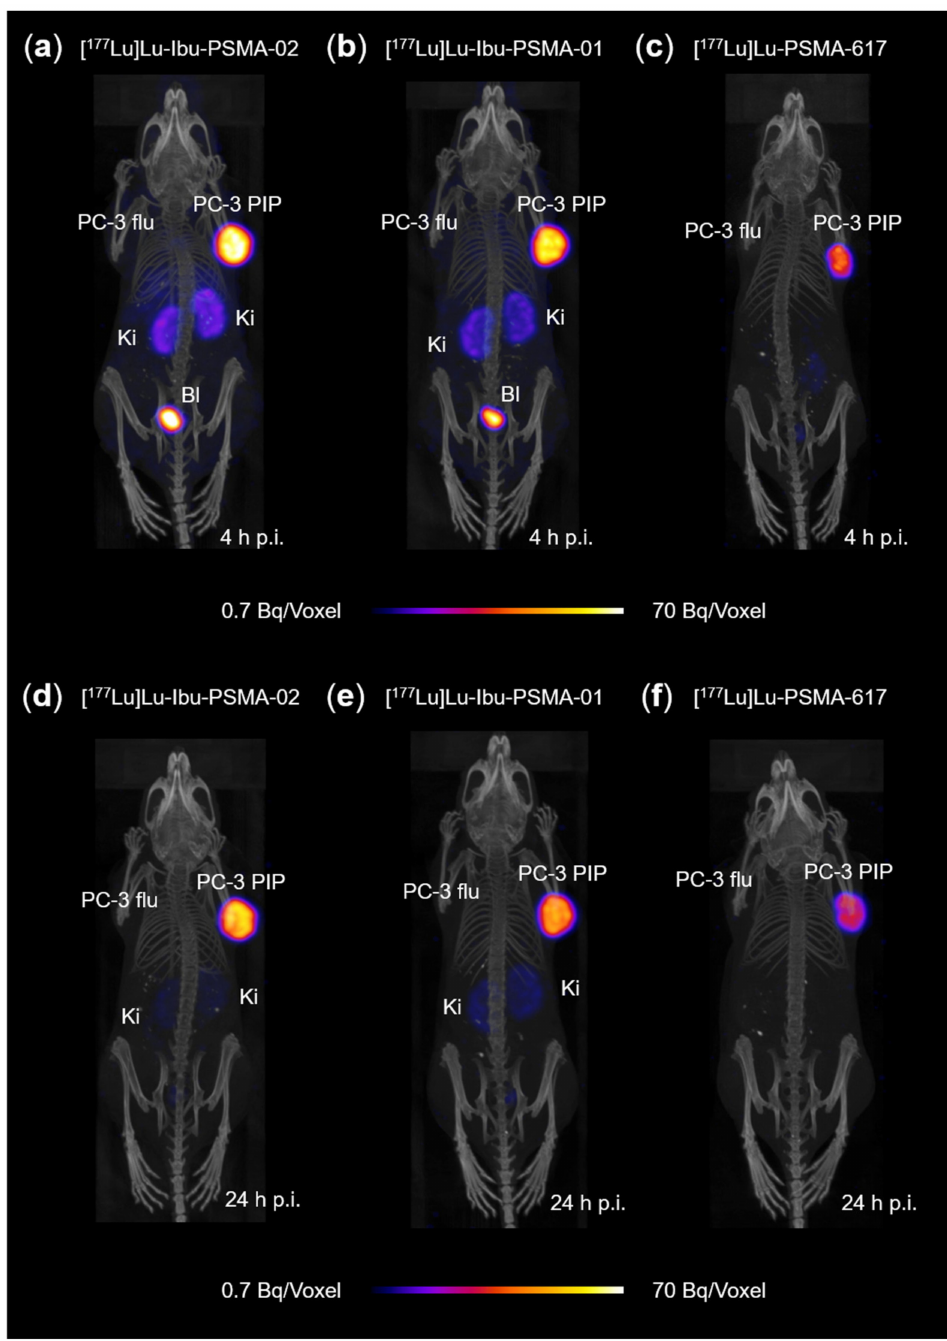
Figure 7. SPECT / CT images obtained 4 h and 24 h after injection of the PSMA radioligands and shown as maximum intensity projections (MIPs); ( a ) MIP of [ 177 Lu]Lu-Ibu-PSMA-02 4 h p.i.; ( b ) MIP of [ 177 Lu]Lu-Ibu-PSMA-01 4 h p.i.; ( c ) MIP of [ 177 Lu]Lu-PSMA-617 4 h p.i.; ( d ) MIP of [ 177 Lu]Lu-Ibu-PSMA-02 24 h p.i.; ( e ) MIP of [ 177 Lu]Lu-Ibu-PSMA-01 24 h p.i. and ( f ) MIP of [ 177 Lu]Lu-PSMA-617 24 h p.i.; PC-3 PIP = PSMA-positive tumor xenograft; PC-3 flu = PSMA-negative tumor xenograft; Ki = kidney; Bl = urinary